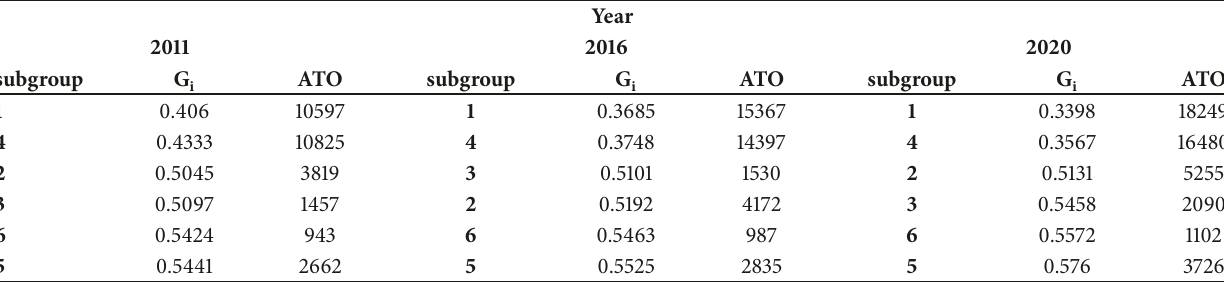
Table 8: The Gini coefficients and transit opportunities of all